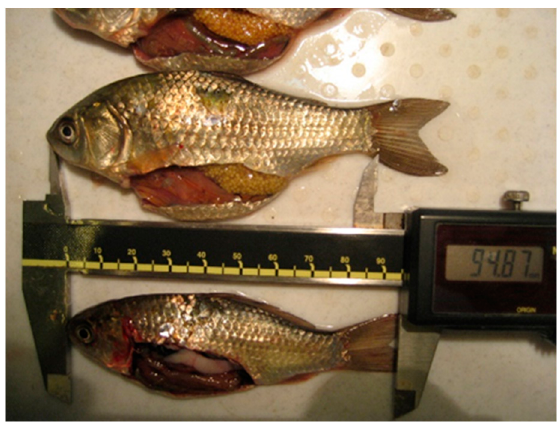
Figure 3. Linear dimensions of Carassius auratus at the age of 5+ from Komsomolsk pond. The ratio of females to males was 1:1. Attention is drawn to the low gastrointestinal filling rate. Perhaps this is due to the consumption of energy reserves in the winter-spring period, which is typical for many cyprinid fish. However, these signs may indicate a limited food supply.